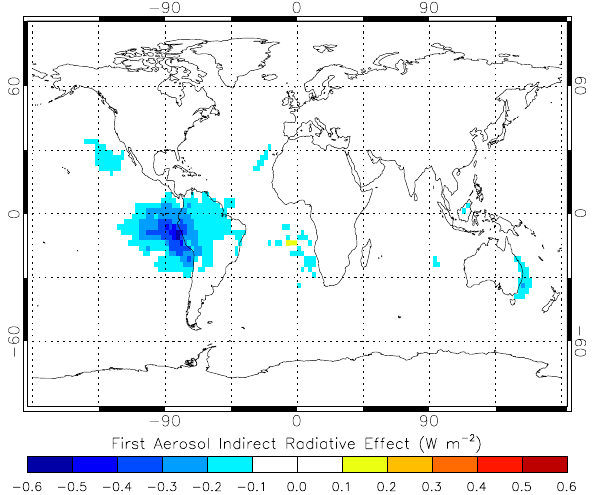
Fig. 9. Annual-mean cloud albedo AIE due to inclusion of CI+SO 2 chemistry with an assumed updraft velocity of 0.2ms − 1 (radiative perturbation between the BASE and BASE-CI